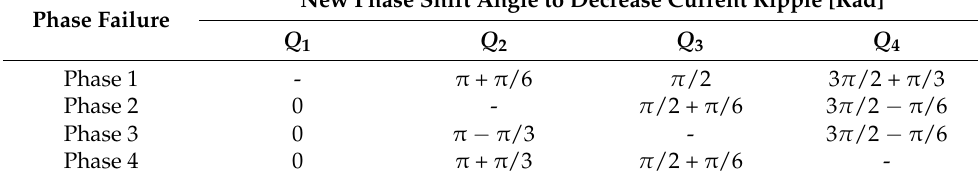
Table 2. Fault-tolerant control strategies of PWM tracking phase failure showing the phase correction added to the value corresponding to the healthy